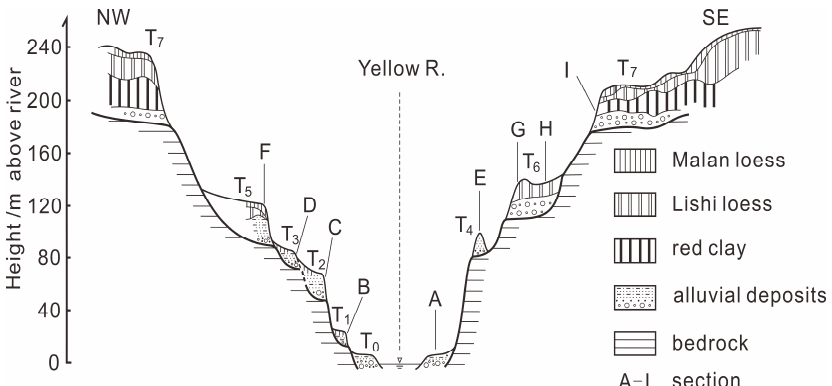
Figure 3. Schematic composite cross-section across the Jinshaan Canyon at the Baode area showing the Yellow River terrace sequence and fluvial and overlying loess/paleosol sections in Figure